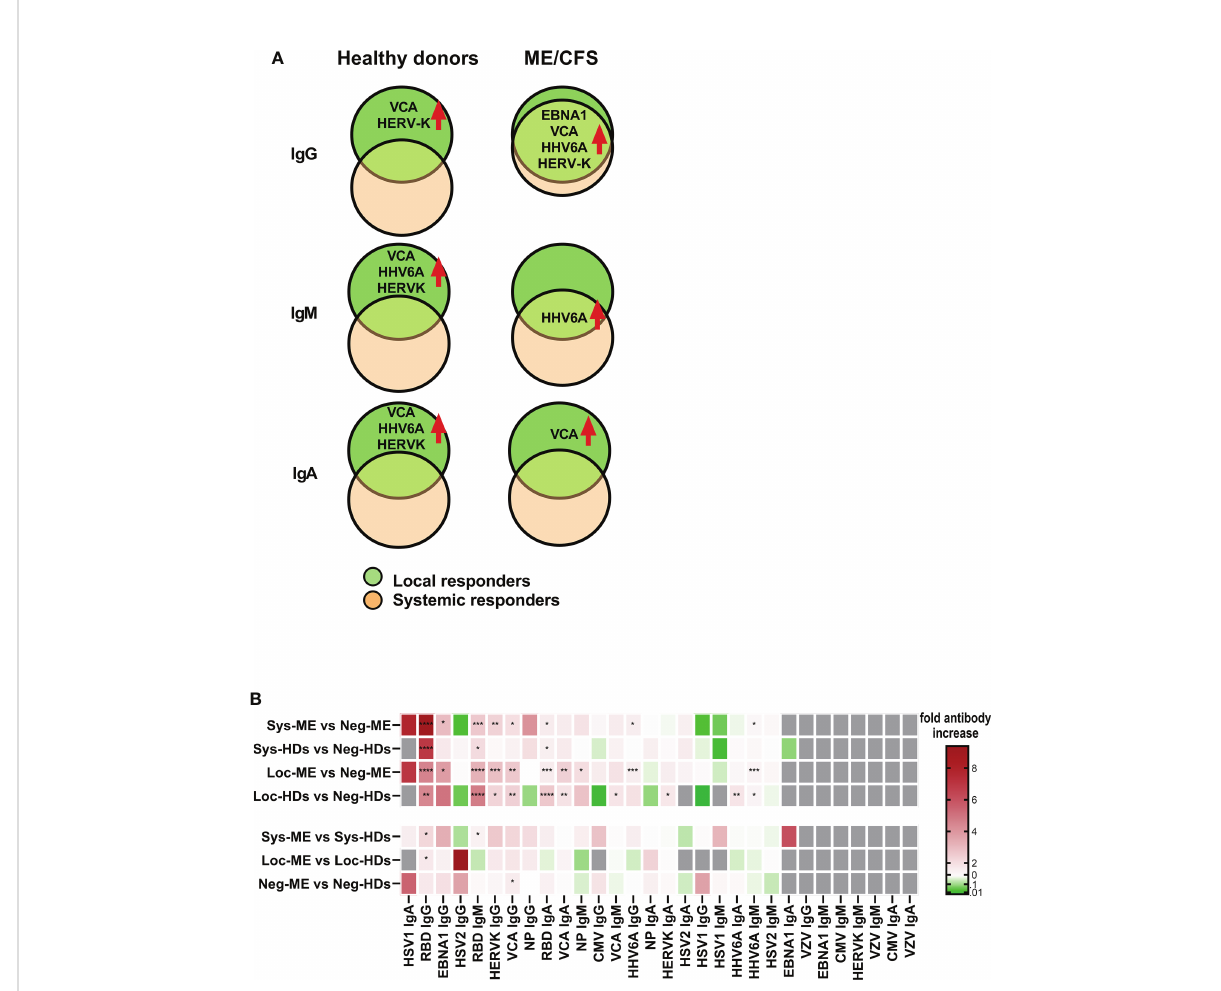
FIGURE 6 Summary of the effect of SARS-CoV-2 infection, regarding latent virus reactivation. (A) Comparison within each cohort based on IgG, IgM, and IgA antibody response fi ngerprint in the oral mucosa. Only antibody responses with statistically signi fi cant differences are displayed on charts. Local responders: Participants RBD-positive for local response in saliva. (B) Hierarchical clustered heatmap showing fold-change of saliva antibody titers in local and systemic responses within and between each group including p -values. Statistically signicant differences according to nonparametric Kruskal/Wallis procedure and false discovery rate adjustment (5%), are indicated as *p < 0.05,**p < 0.01, ***p < 0.001 and ****p < 0.0001